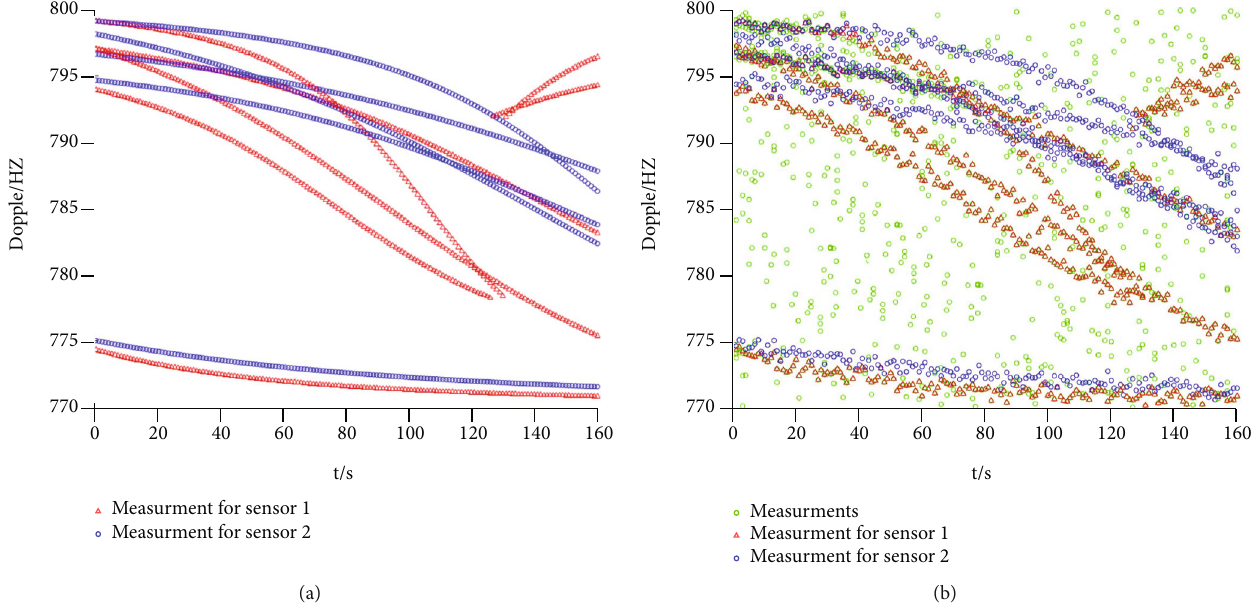
Figure 5: Doppler measurements for two static passive sensors: (a) the true Doppler measurements without clutter; (b) synthetic Doppler measurements with